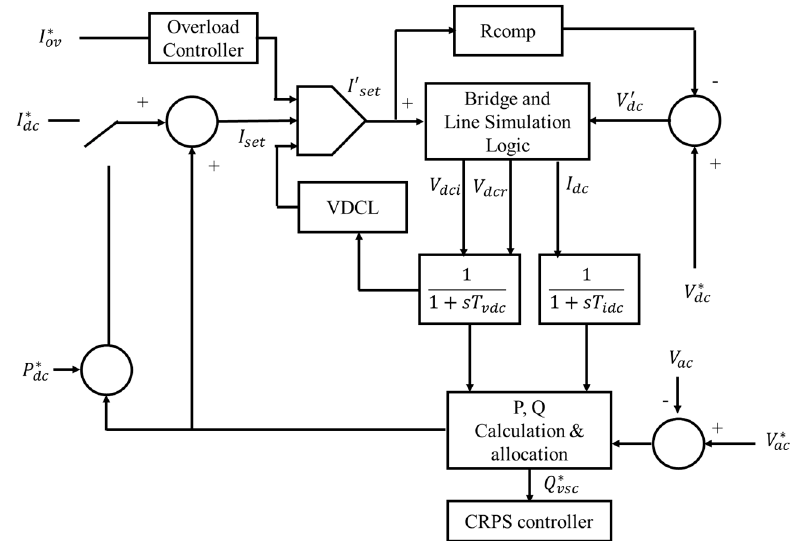
Figure 5. Block diagram of the dynamic model for the hybrid MTDC.